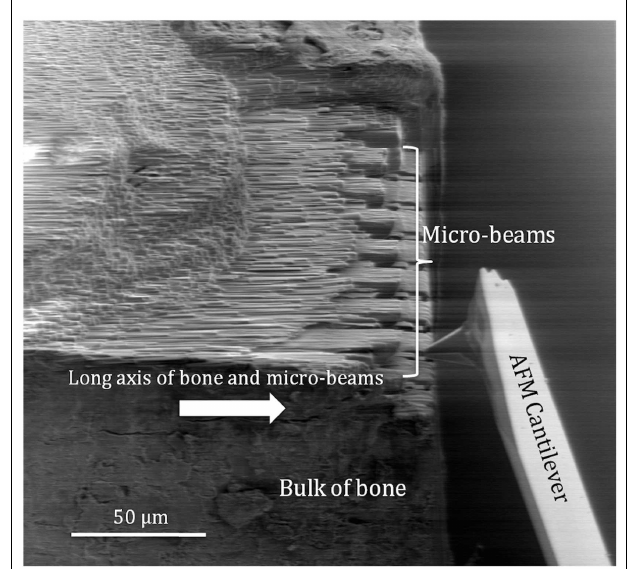
FIGURE 1 | Scanning electron micrograph of theAFM tip attached to the force detection system of theAFM cantilever approaching a bone micro-beam for in situ mechanical testing .The arrow indicates the direction of the long axis of bone and micro-beam principal